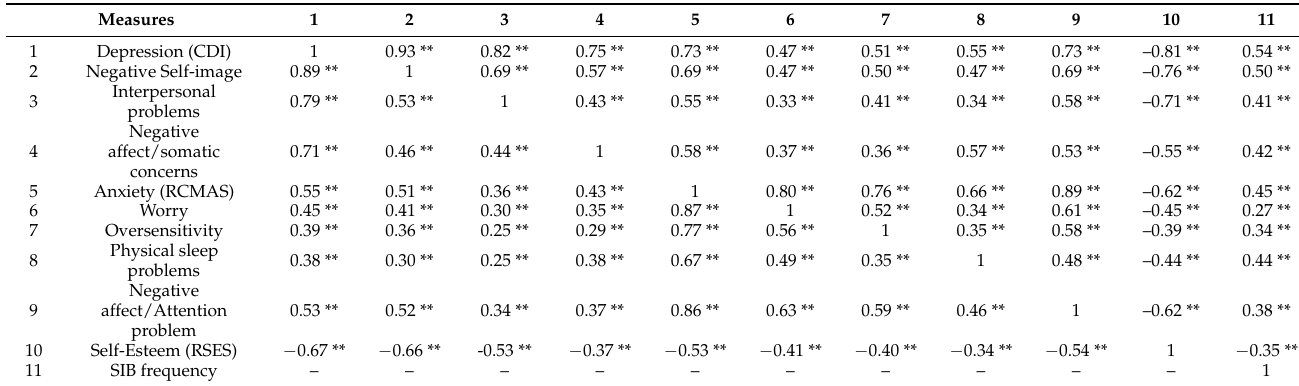
Table 5. Correlations of related variables.